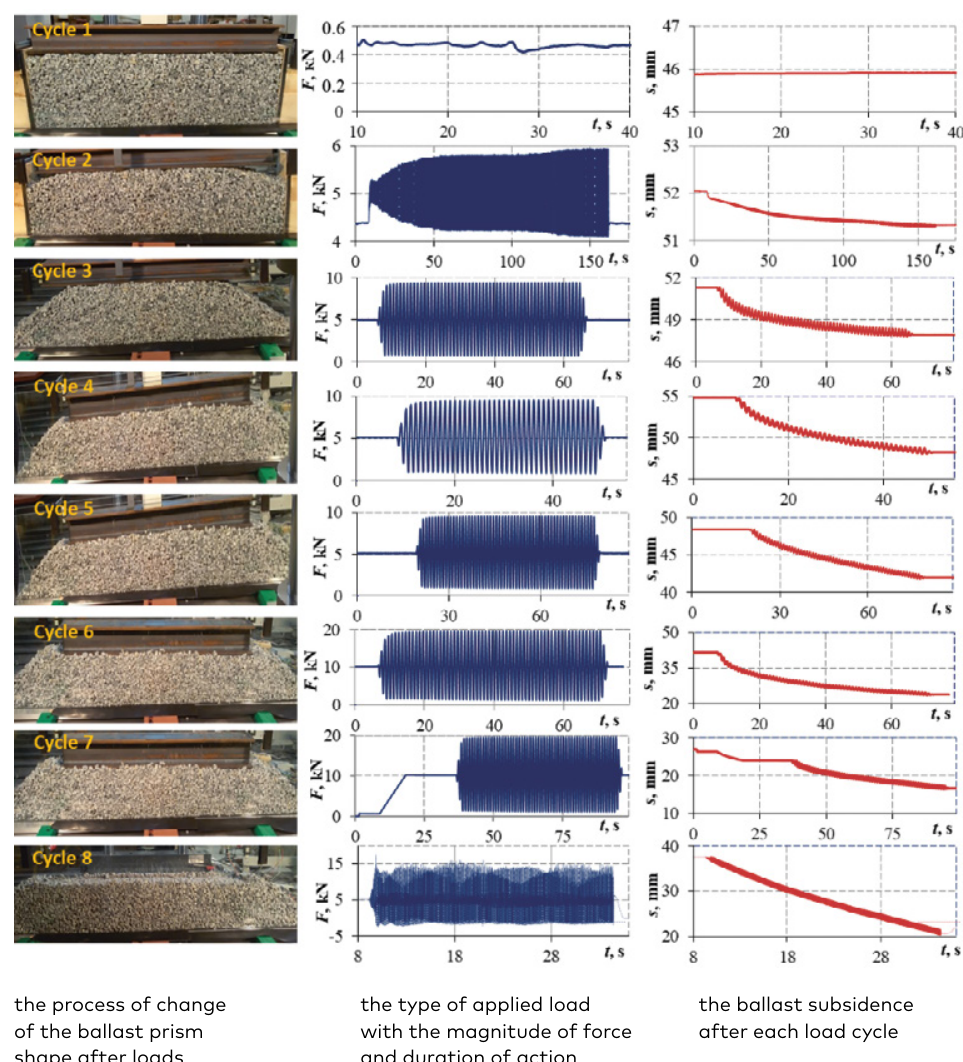
Figure 5. The process of studying the stressed state of the ballast under laboratory conditions